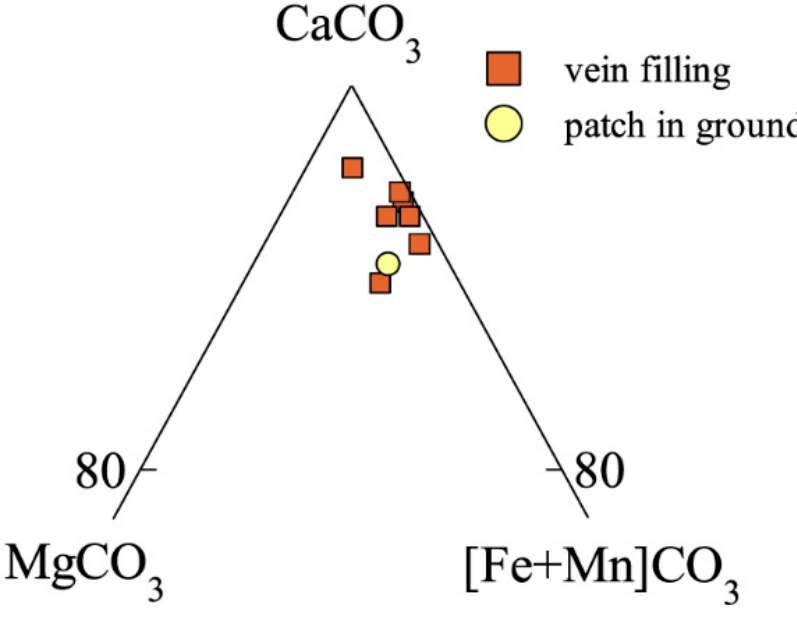
Figure 6. MgCO 3 -CaCO 3 -[Fe+Mn]CO 3 Figure 6. MgCO volcanic rocks.